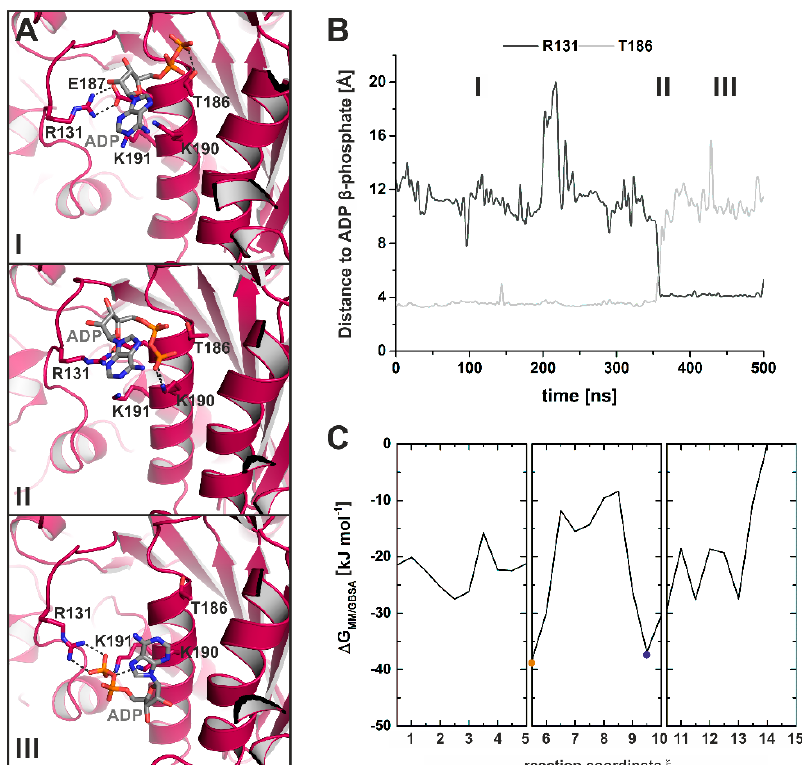
Figure 8. Unbiased MD simulations captured a potential ADP release pathway. ( A ) Molecular events during ADP dissociation along the unbiased MD trajectories reveal a guiding mechanism of Arg131 together with Thr186. Panels I through III show snapshots along the cMD trajectory. ( B ) Distance of the protein residues Arg131 and Thr186 to the nucleotide β -phosphate over the MD simulations illustrate the interplay between the two protein residues in the proposed ADP release mechanism. ( C ) Energy profile of the reconstructed ADP release pathway from a strongly bound ADP to nucleotide dissociation as determined by the molecular mechanics / generalized-born surface area (MM / GBSA) interaction energy between the protein and ADP, obtained by combining TMD and cMD trajectories. Both the myosin conformation with strongly bound ADP (orange dot) and the myosin conformation resembling our myosin-II · ADP · blebbistatin structure (blue dot) represent energy minima (low-energy conformations) along the reconstructed myosin power